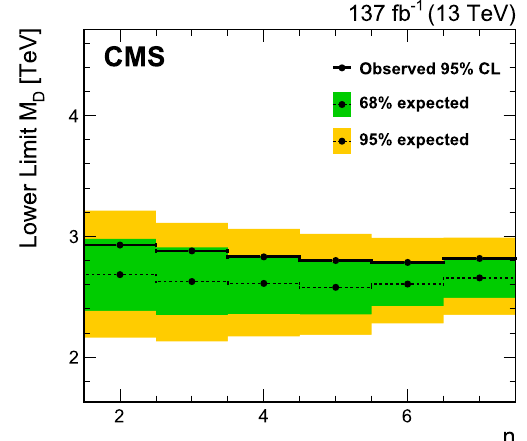
Fig. 12 The 95% CL expected and observed exclusion limits on M D as a function of the number of extra dimensions n